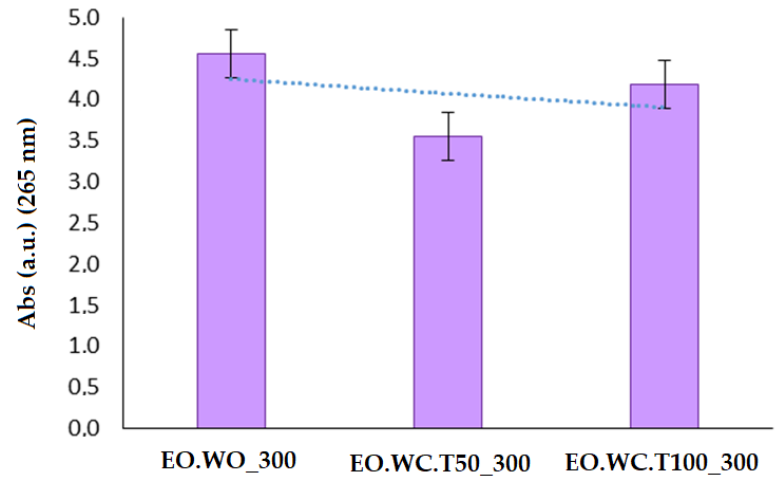
Figure 3. Maximum absorption at 265 nm obtained for separated solvents from EO.WO_300, EO.WC.T50_300 and EO.WCT100_300 samples (Table 4).